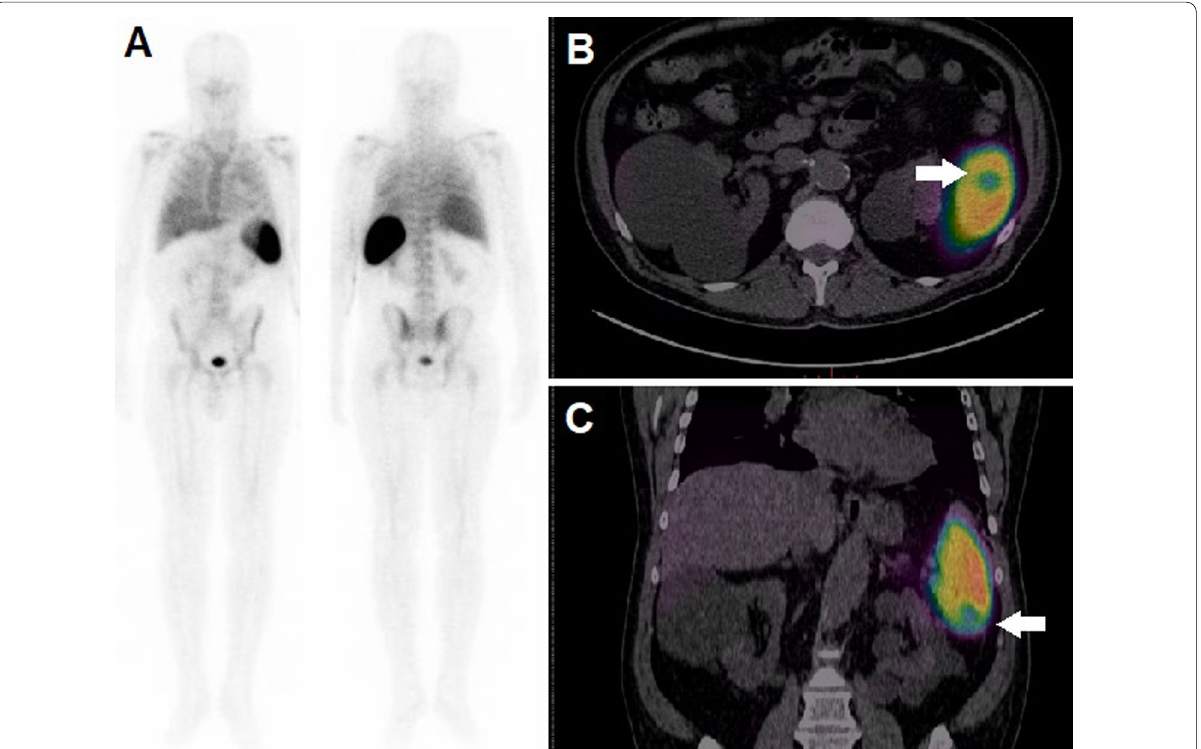
Fig. 2 99m Tc-HMPAO WBC scan ( a ) in anterior (left) and posterior (right) view at 2 h p.i. did not detect any areas of pathological accumulation of the labeled cells. Fused axial ( b ) and coronal ( c ) slices demonstrated a photopenic area (white arrow) in the spleen inferior pole, corresponding to the hypermetabolic finding detected at 18 F-FDG